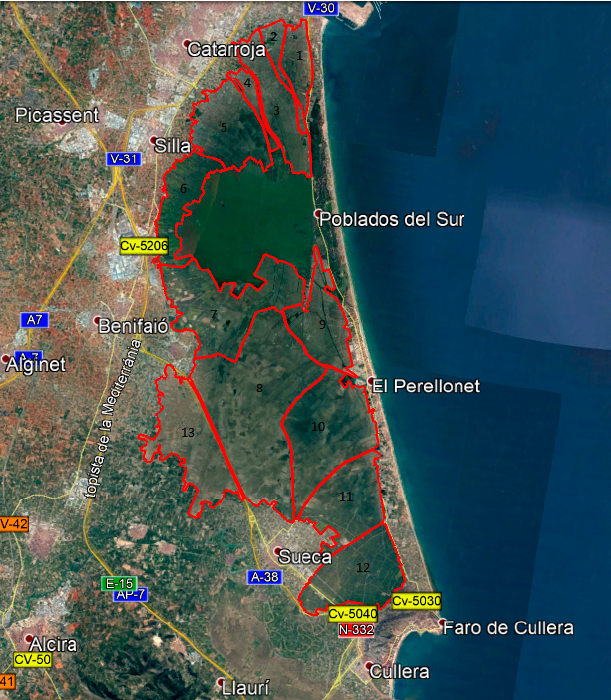
Figure 1. Image of rice crop area in the P.N. Albufera de València and the actuation zones into which it was divided (Image source: Google Earth. Modified by J.M. Giner).